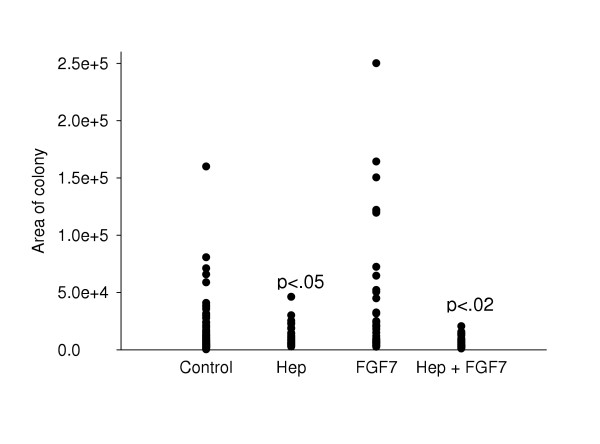
Distribution of tumor cell colony sizes. The average sizes of the tumor cell colonies as measured by digital image analysis were 16,428 pixels for the control; 9917 pixels for heparin alone; 35,760 pixels for FGF-7 alone; and 5551 pixels for the cells treated with heparin and FGF-7. Heparin significantly reduced the distribution of colony sizes in the presence or absence or FGF-7 as determined by a Mann-Whitney U-test.